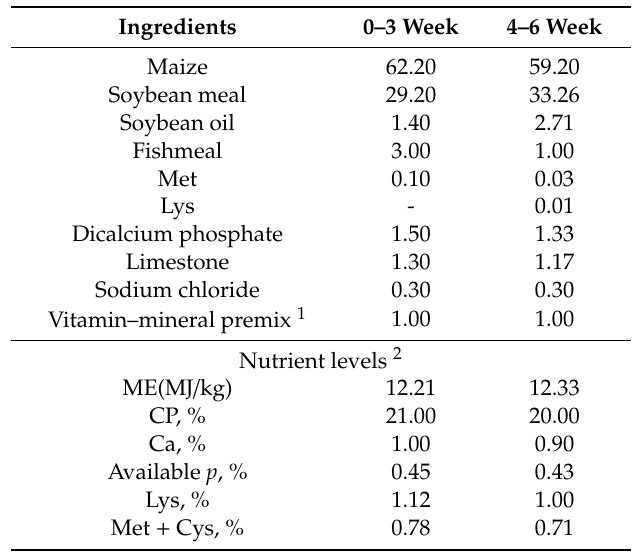
Table 1. Composition (%) and nutrient levels of diets (air dry